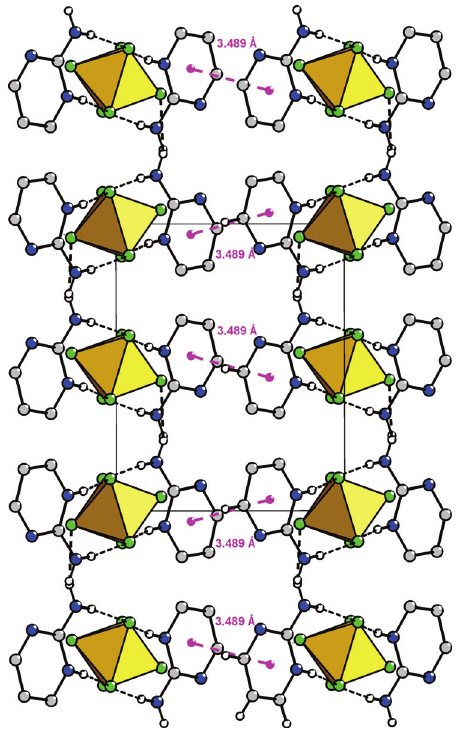
Figure 4. Detail of the crystal packing of 3 depicting the π – π inte- ractions between aromatic rings. Hydrogen atoms not involved in hydrogen bonding have been omitted for